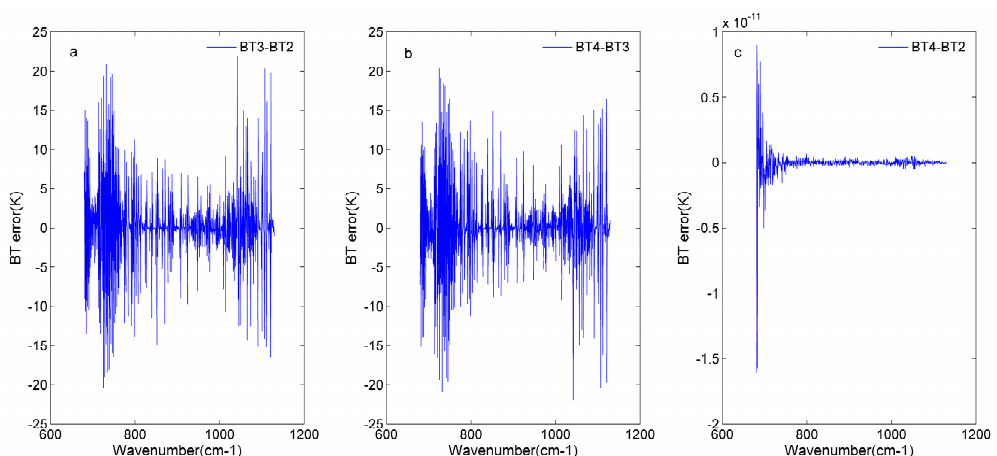
Figure 11. Brightness temperature (BT) error before and after off-axis correction for detector 81: ( a ) BT error in the input spectrum (BT2) and the spectrum with off-axis effects (BT3); ( b ) BT error in the spectrum with off-axis effects (BT3) and the spectrum after off-axis correction (BT4); ( c ) BT error in the spectrum after off-axis correction (BT4) and the input spectrum (BT2).